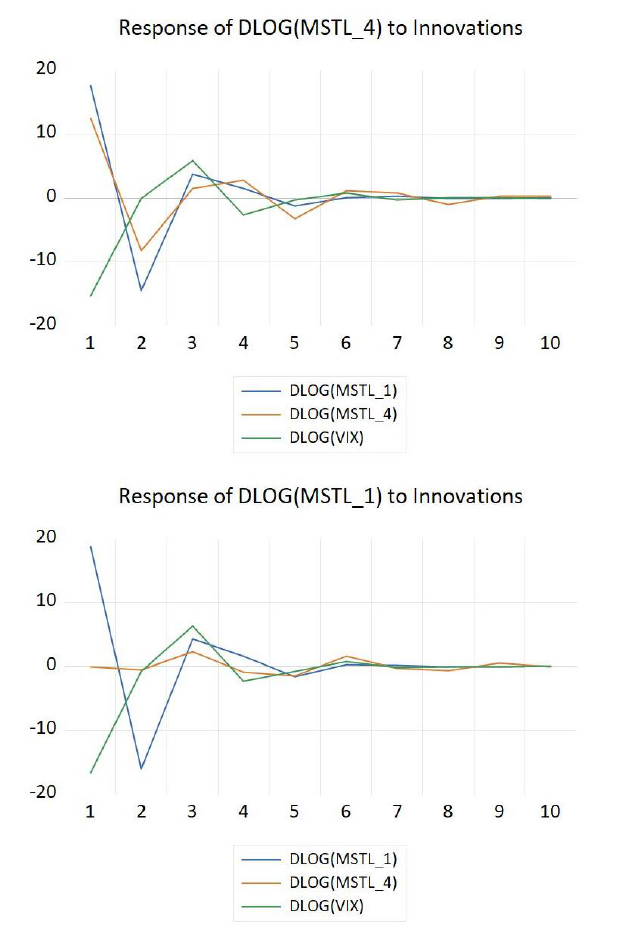
Figure 4. Impulse response function analysis. This figure shows the response to Cholesky One Standard Deviation innovations ± 2 analytic asymptotic Standard Errors to MSTL_Q4 ( up ) and MSTL_Q1 ( down ), respectively. Blue line represents the answer to a MSTL_Q1 innovation. Orange line shows the answer to a MSTL_Q4 innovation. Finally, green line represents the answer to a VIX innovation. Source: authors ’ elaboration.